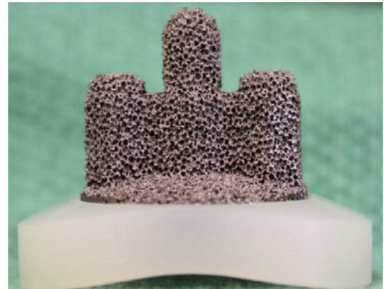
Figure 8: The total shoulder implant with the porous tantalum-based material